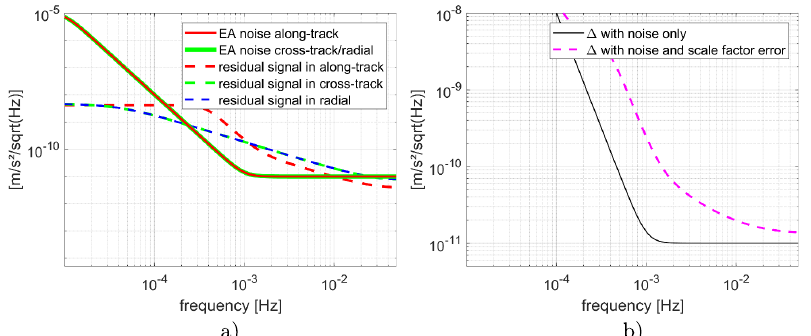
Figure 15. Retrieval error with scale factor and instrument noise contributors, considering a stand- alone EA ( a ) and the corresponding LOS projection ( b